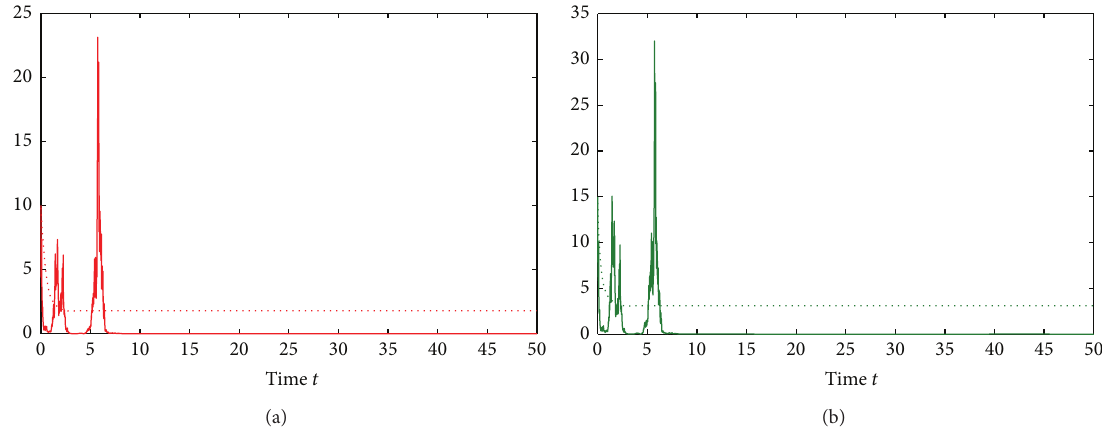
Figure 1: Computer simulation of paths 𝐼 1 (𝑡) , 𝐼 2 (𝑡) for the system (18) and its corresponding deterministic model, using the EM method with step size 0.001, with initial values 𝐼 1 (0) = 10 , 𝐼 2 (0) = 20 . The full line expresses stochastic model’s simulation, and the dotted line expresses the related deterministic model.